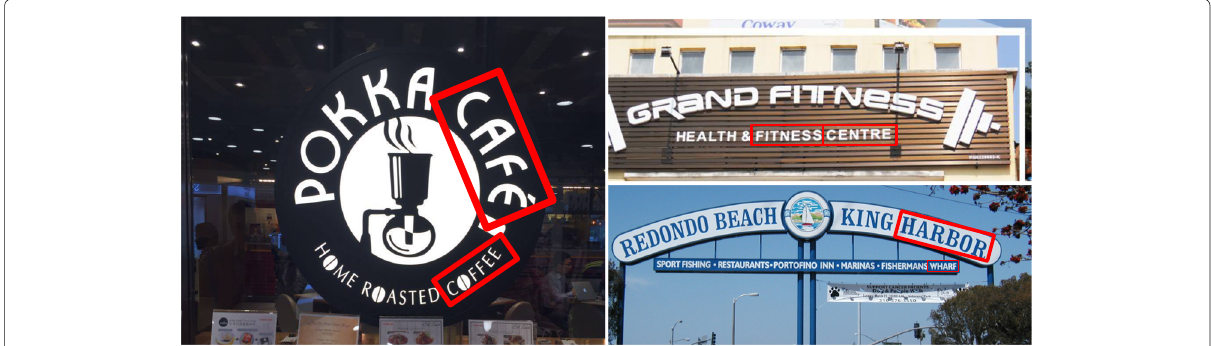
Fig. 1 Examples of real scene text images from